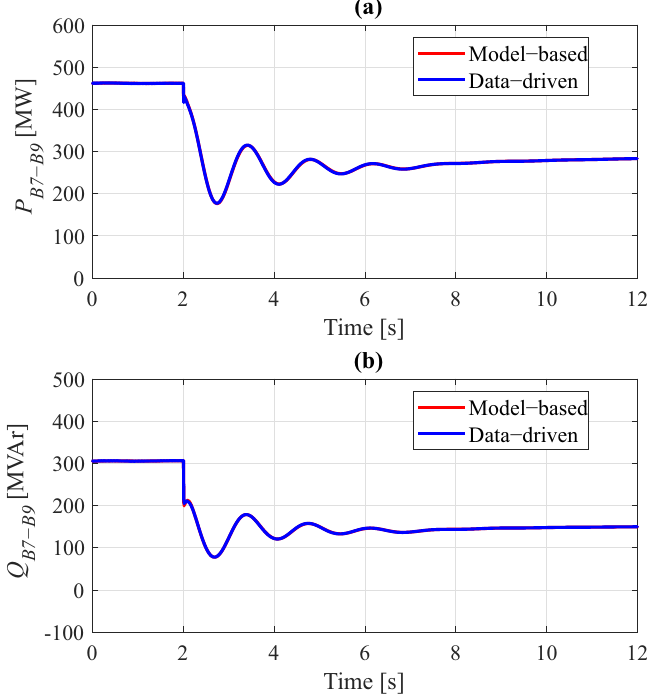
Figure 15. Power flows during load shedding: ( a ) active power, and ( b ) reactive